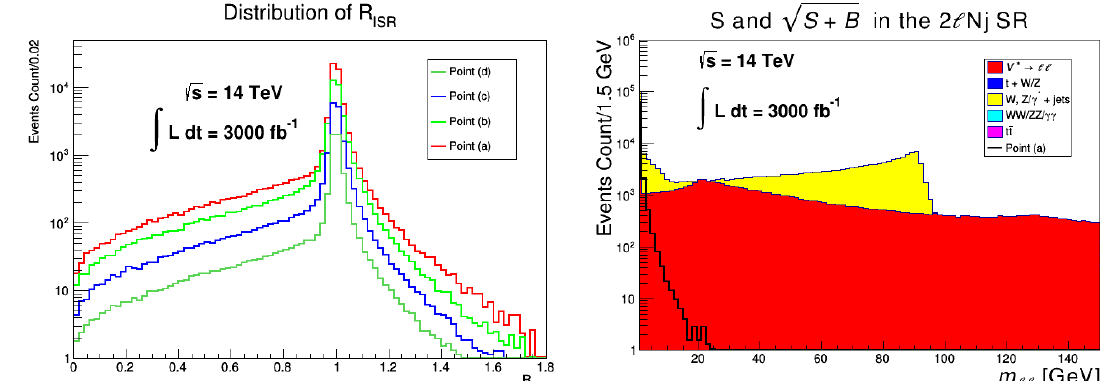
Figure 4. Left panel: distributions in the variable R ISR for four benchmarks (a), (b), (c) and (d) at 14 TeV and 3000 fb (cid:0) 1 of integrated luminosity. Right panel: distribution in the dilepton invariant mass for the SM background and benchmark